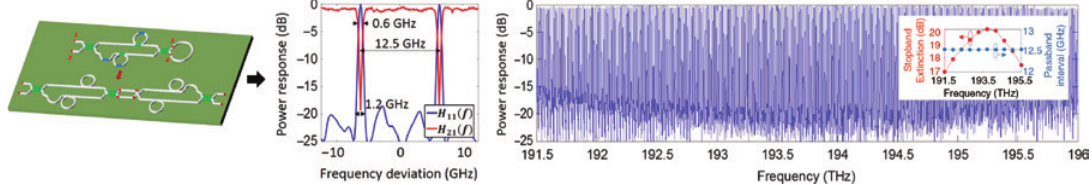
Figure 15: Design and realization of a highly reconfigurable RAMZI circuit: implementation of a full C-band comb filter with an RAMZI incor- porated in a Sagnac loop [84].